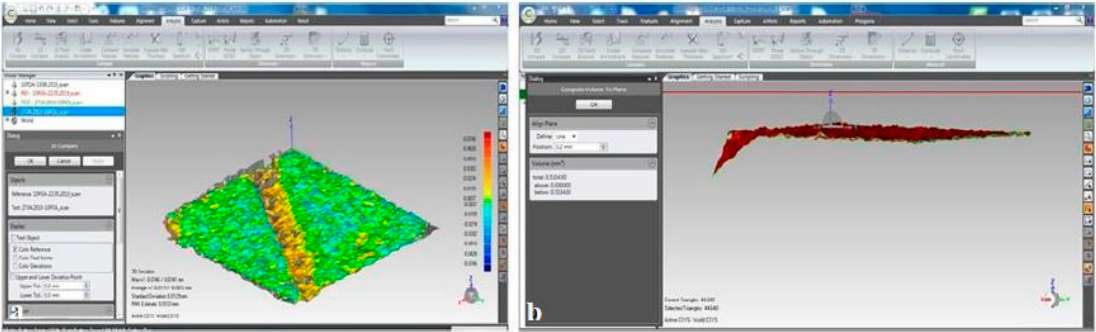
Figure 4. Screenshots of the software used to calculate wear values ( a ). Duplicated layers after instrumentation, ( b ). Following duplication, an imaginary line was drawn 0.2 mm away from the duplicated plane to measure the volume under the line.